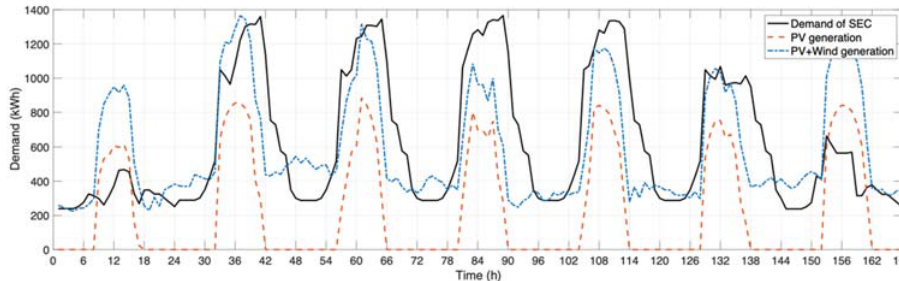
Figure 4. An example of VPP implementation for a commercial SEC.